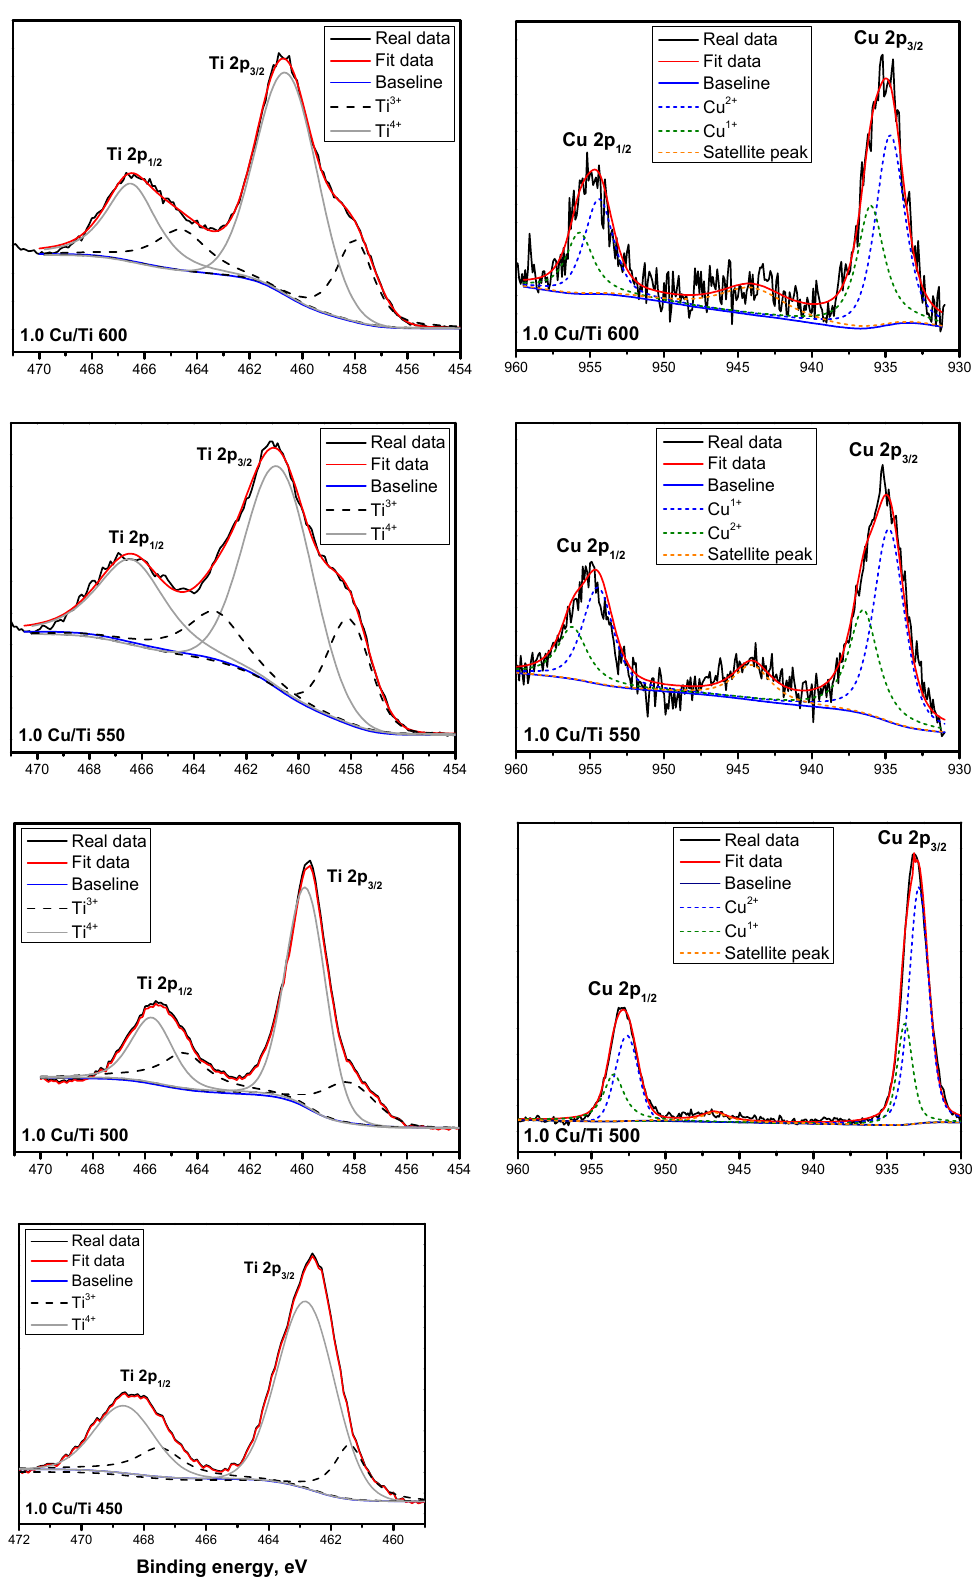
Figure 5. XPS high-resolution spectra over Ti 2p peaks ( left ) and Cu 2p peaks ( right ) for the Cu/Ti photocatalysts at different temperatures and copper